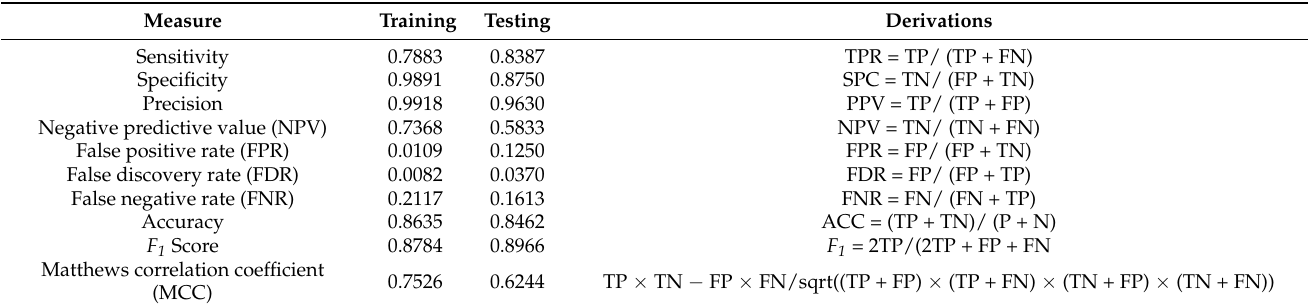
Table 6. The validation index of the training and validation sets. All validation indices were calculated through the four parameters of TP, FP, TN, and FN. In addition to the FPR, FDR, and FNR, most of the validation indices are higher than 0.7. Only NPV and MCC in the testing set are lower than 0.7. Measure